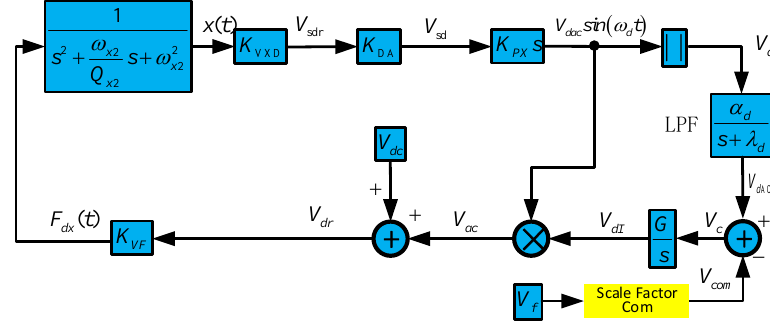
Figure 4. MEMS gyroscope, drive mode closed-loop system.